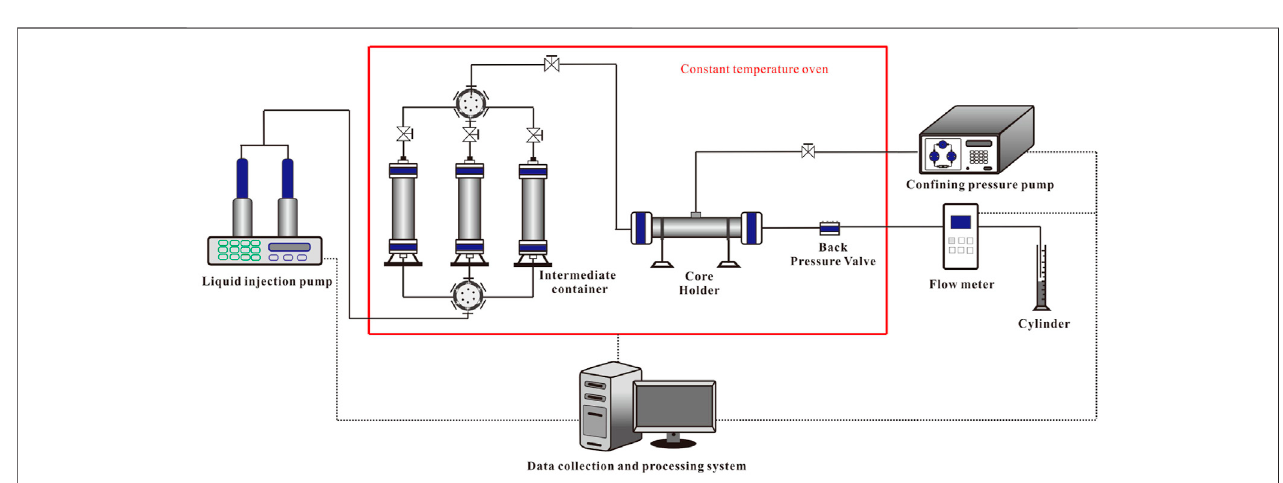
FIGURE 6 | Core displacement equipment fl owchart.